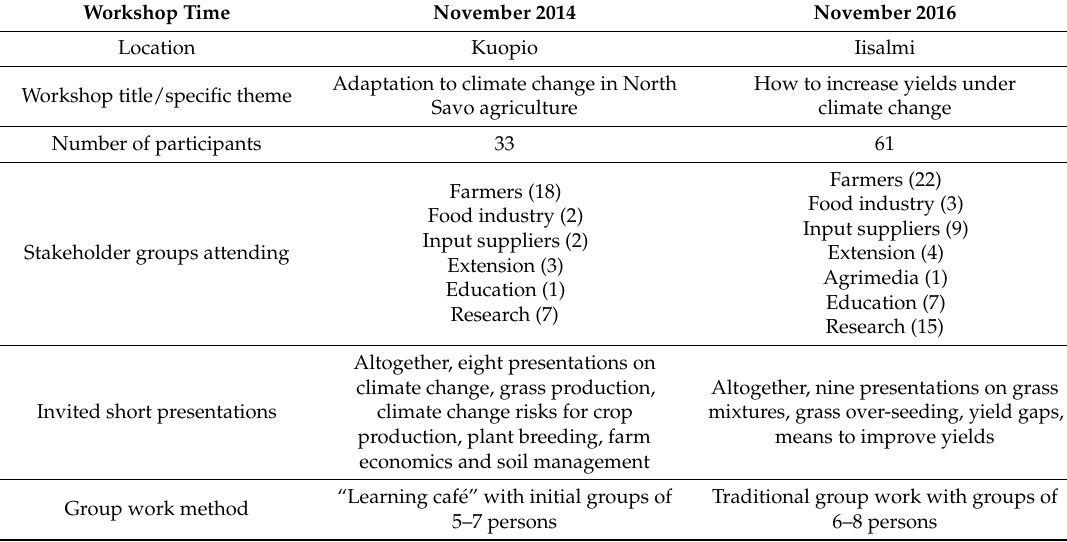
Table 1. An overview of the two workshops organized in Kuopio in 2014 and Iisalmi in